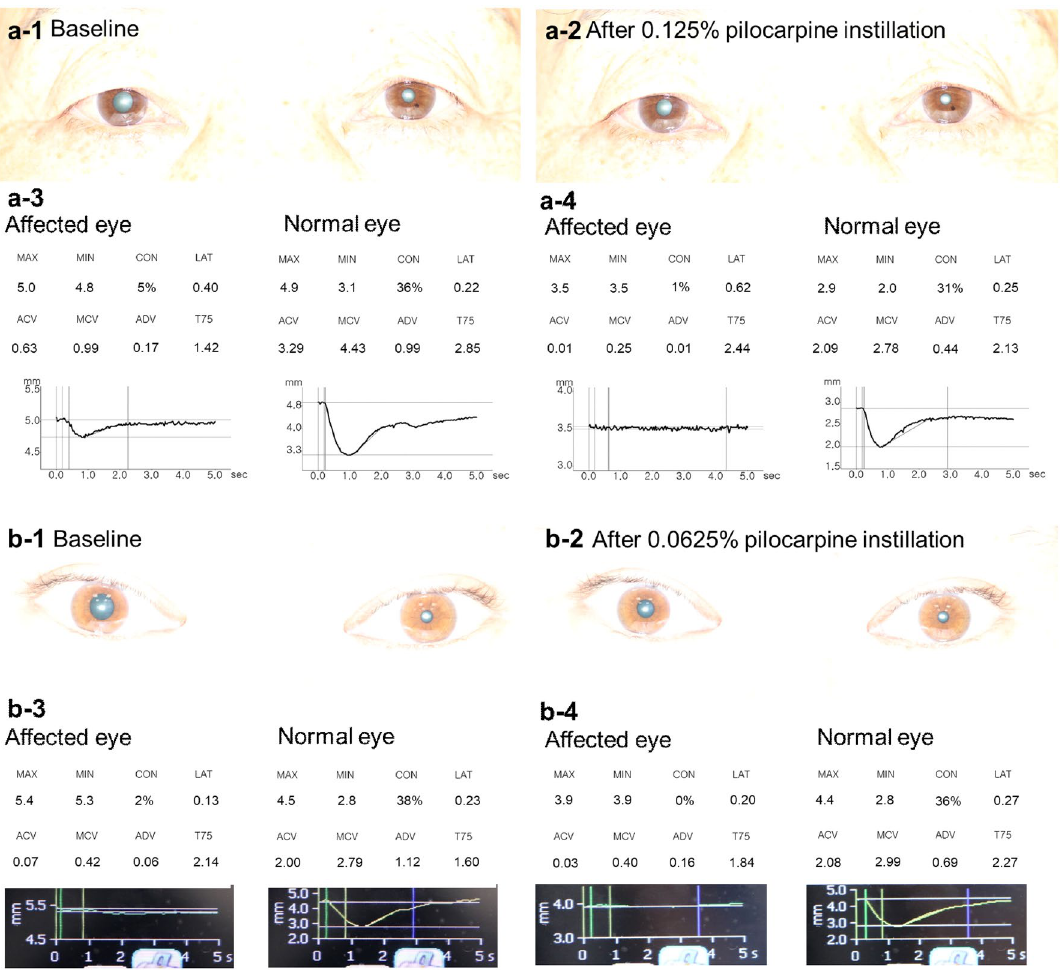
Figure 2. Representative cases of dilute pilocarpine test in unilateral Adie’s tonic pupil. The pupillary light reflex (PLR) was recorded with a digital pupillometer. Pupil photographs were taken at baseline (a-1 and b-1) and 30–40 min after pharmacological testing (a-2 and b-2). Both patients at baseline showed mydriasis in the right eye (a-1 and b-1). Eight pupillary light reflex parameters were presented with pupil response curves at baseline (a-3 and b-3) and after 0.125% pilocarpine (a-4) and 0.0625% pilocarpine (b-4) instillation. Thirty minutes after instillation of 0.125% pilocarpine in both eyes, maximal and minimal pupil sizes reduced by 1.5 and 1.3 mm in the affected eye and 2.0 and 1.1 mm in the normal fellow eye (a-3 and a-4). In the patient who underwent 0.0625% pilocarpine testing, the normal fellow eye showed minimal change of maximal and minimal pupil diameters (0.1 mm and no change, respectively) (b-3 and b-4). On the contrary, maximal and minimal pupil diameters of the affected eye reduced by 1.5 and 1.4 mm, respectively. Note that the amount of change in anisocoria from baseline to post-pilocarpine test was 0.2 mm after instillation of 0.125% pilocarpine ( a ) and 1.4 mm after 0.0625% pilocarpine instillation ( b ). ACV = Average constriction velocity; ADV = Average dilation velocity; CON = Pupil constriction ratio; LAT = latency; MAX = maximal pupil diameter; MCV = Maximal constriction velocity; MIN = Minimal pupil diameter; T75 = Total time from the peak of constriction to the recovery of the pupil to 75% of maximal pupil